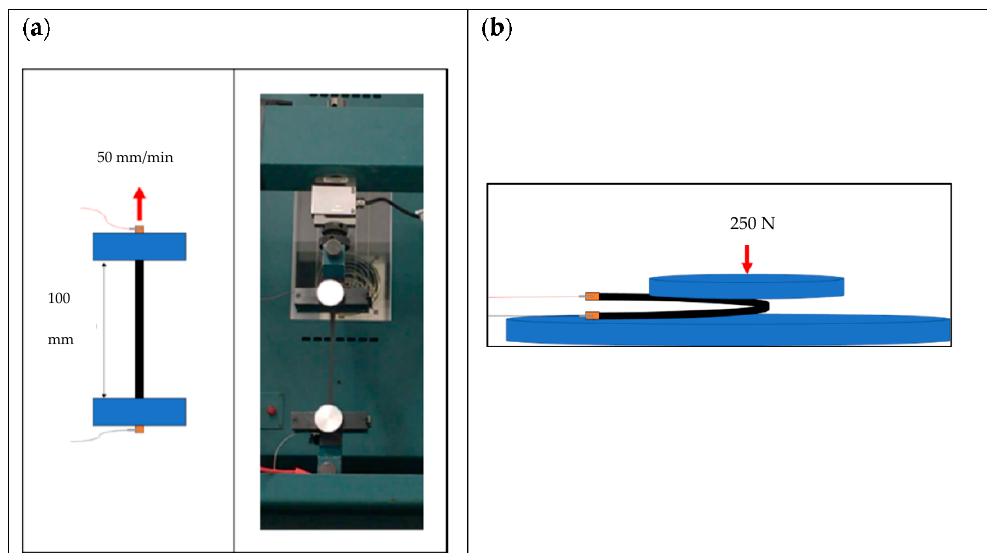
Figure 1. Electromechanical testing of the stretchable inks. ( a ) Simultaneous measurement of electrical and extensional tensile properties ( b ) Simultaneous compression and measurement of electrical properties.